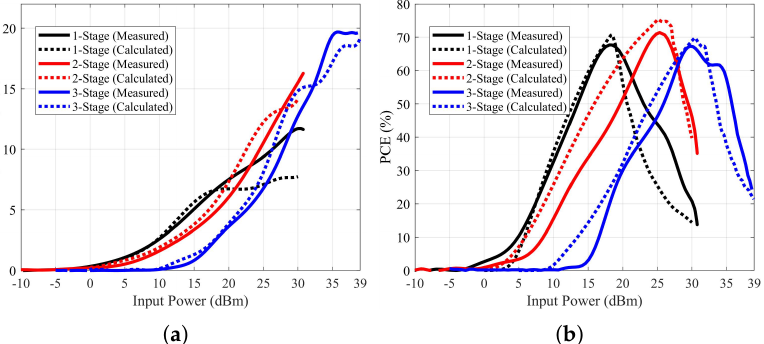
Figure 10. Measured and calculated output voltage and PCE of N-Stage HTVM; ( a ) output voltage and ( b ) PCE.